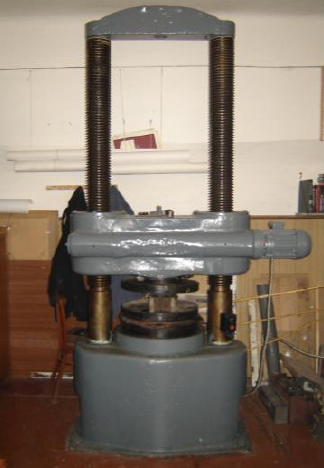
Fig. 1. Hydraulic press PSU-250: Technical